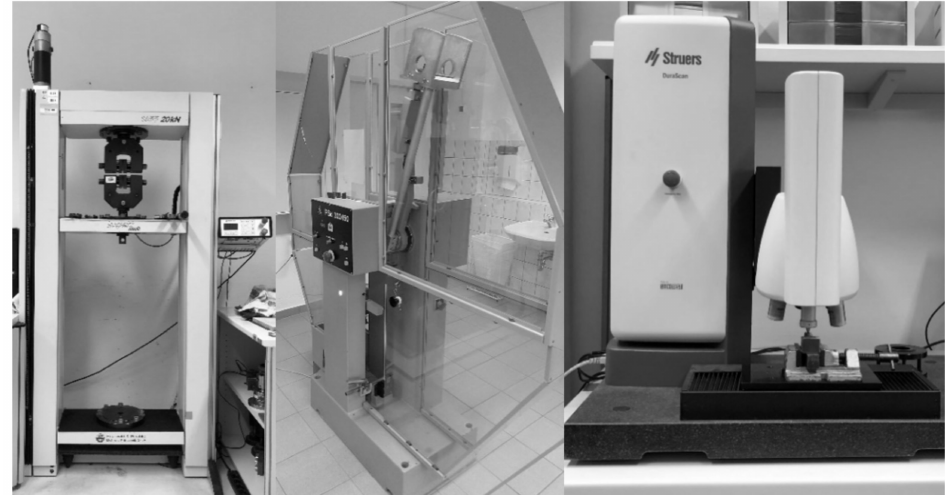
Figure 5. Testing equipment for mechanical properties; left : universal testing machine Zwick 1455, middle : WPM PSd 300/150, right : Struers DuraScan